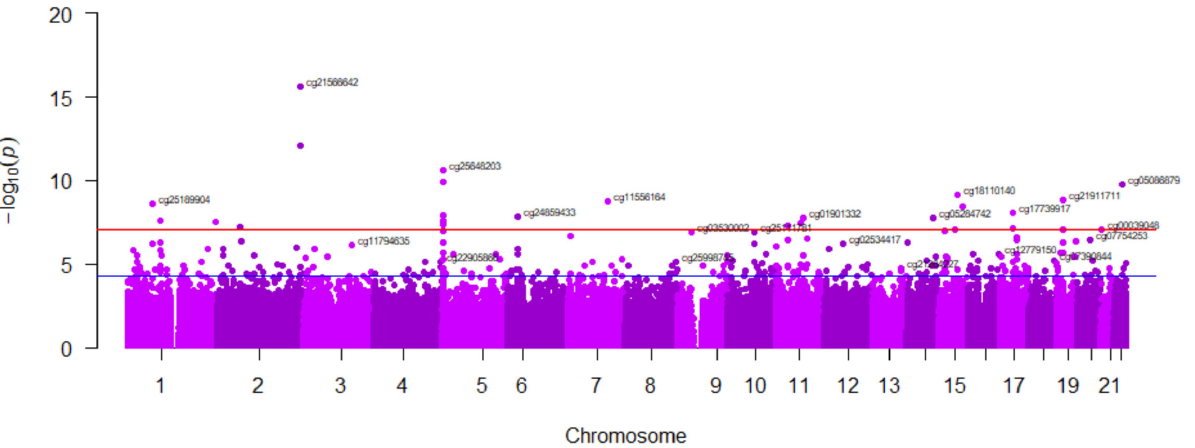
Figure 5. Manhattan plot of the epigenome-wide association among former smokers relative to current smokers (multivariate adjusted). Red line represents the EWAS significance level p = 9 × 10 − 8 . The blue line represents p = 1 × 10 − 5 . The GRCh37/hg19 assembly has been used.